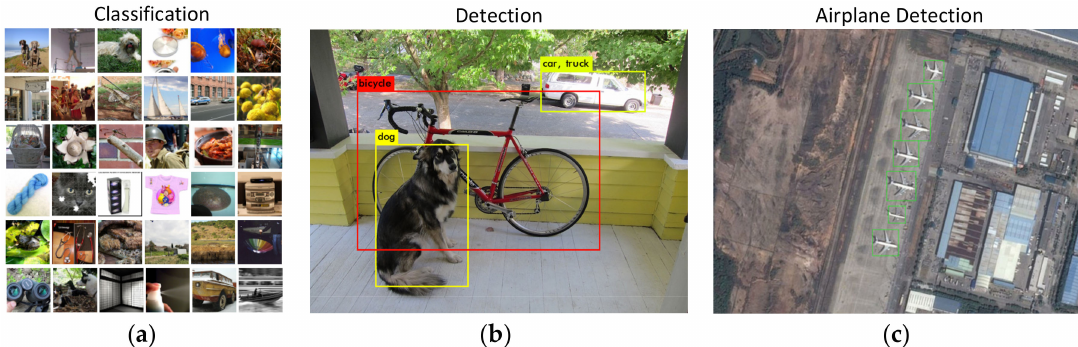
Figure 2. Transfer learning. The model trained by classification tasks can be used as our base network, and then the object detection framework in the natural image can be used to detect the airplane in the remote sensing image. ( a ) ImageNet dataset used for classification [4]; ( b ) the object detection result of a natural image, using YOLO (You Look Only Once); and ( c ) airplane detection in this paper.